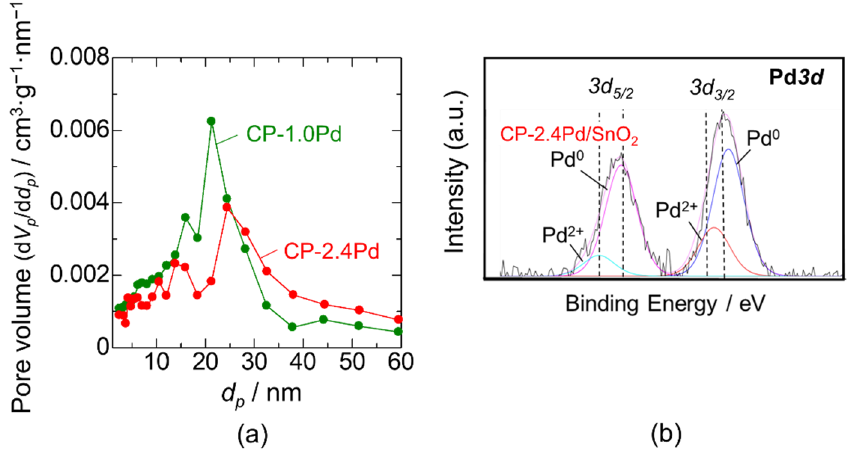
Figure 7. ( a ) Pore distribution of CP-1.0Pd/SnO 2 and CP-2.4Pd/SnO 2 . ( b ) XPS spectrum of Pd 3d using CP-2.4Pd/SnO 2 .